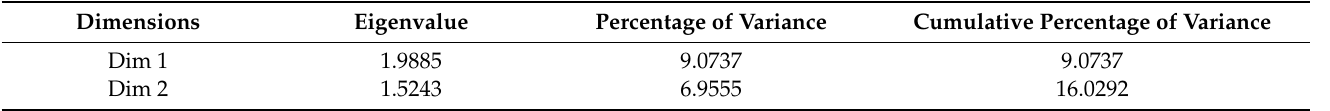
Table 1. Eigenvalues and cumulative variance percentage.